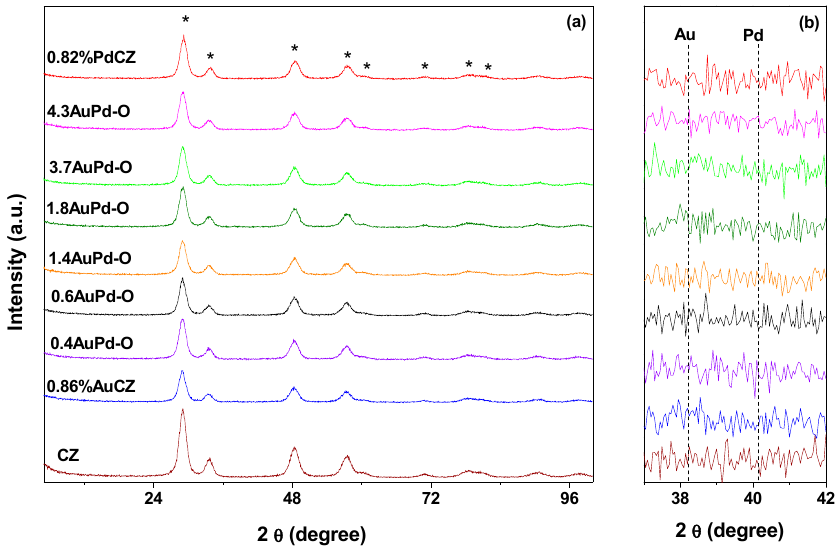
Figure 1. ( a ) XRD patterns of monometallic 0.86%AuCZ, 0.82%PdCZ and bimetallic Au-Pd catalysts with different Au:Pd molar ratios; ( b ) The enlarged diffraction profiles in the 2 θ range between 37° and 42°. * Diffraction of the cubic fluorite structure for Ce 0.62 Zr 0.38 O 2 mixed oxide.